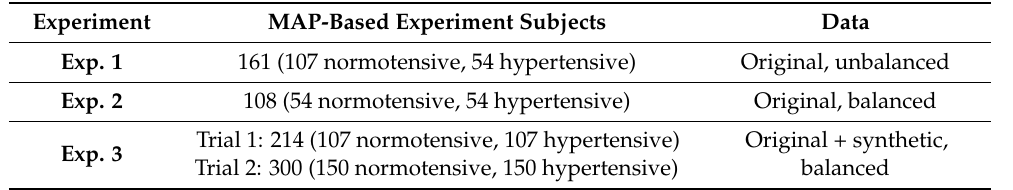
Table 7. Stage 2. MAP-based